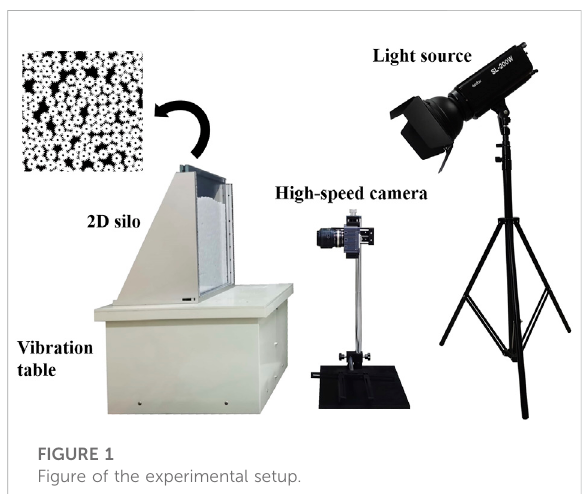
FIGURE 1 Figure of the experimental